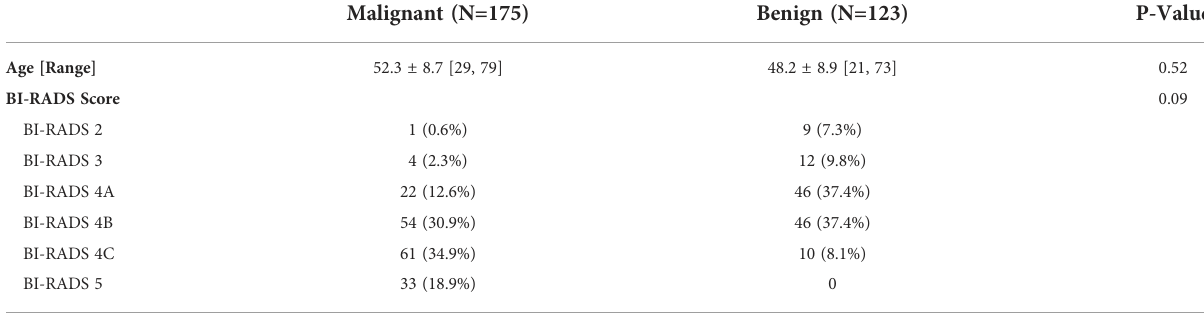
TABLE 1 Age and BI-RADS of lesions determined on DBT in the study